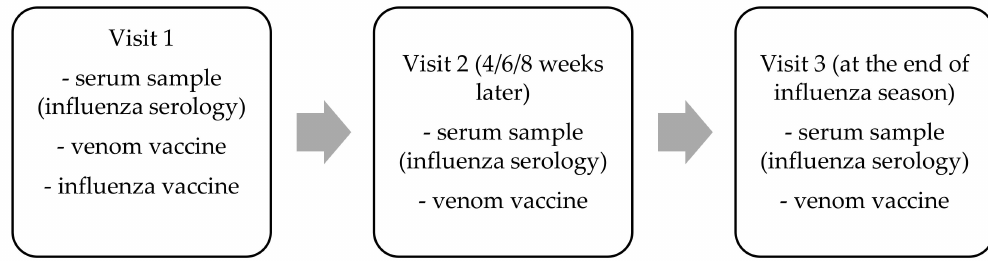
Figure 1. Study scheme among study group patients.